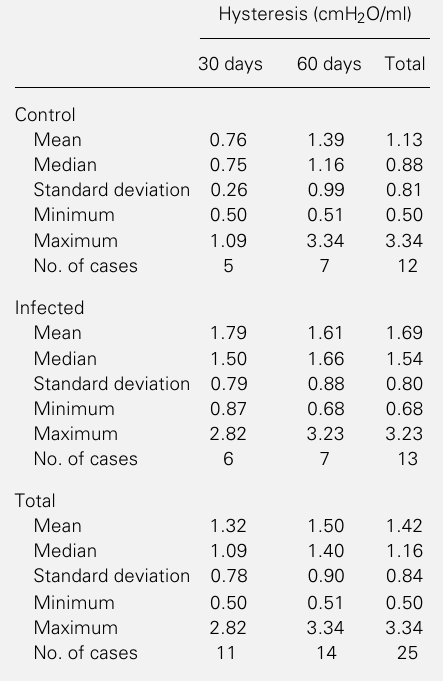
Table 1 - Effect of paracoccidioidomycosis infec- tion on pulmonary hysteresis. P = 0.024, significance of paracoccidioidomycosis infection (ANOVA). P = 0.491 and P = 0.174, time of infection and interaction infection vs time (not significant,